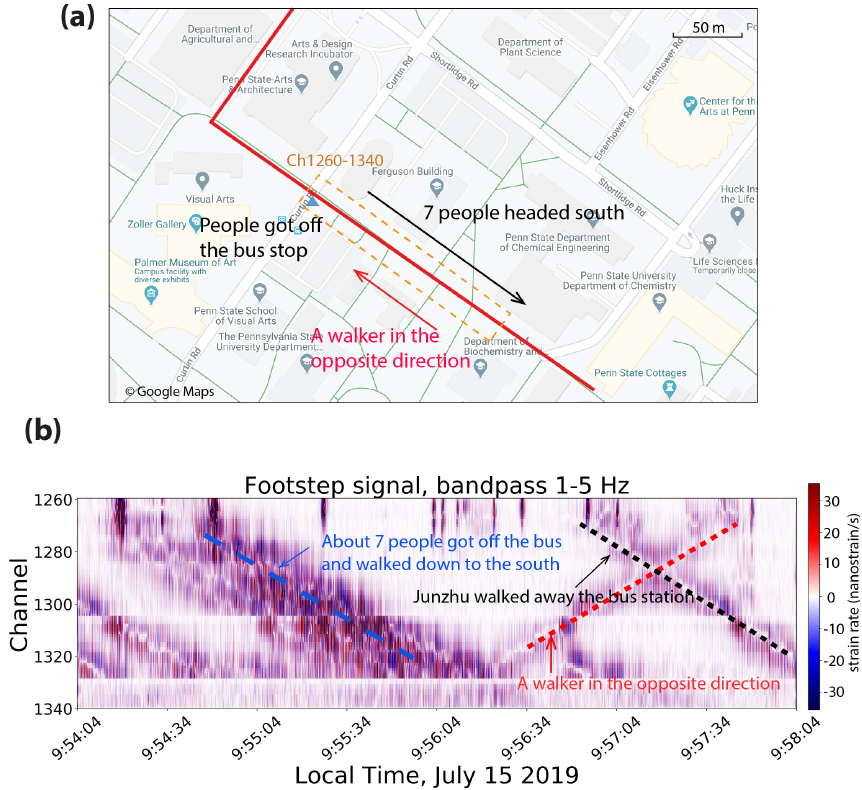
Figure 10. (a) Map of the array and walker information; (b) band-passed data between 1 and 5Hz. Dashed black and blue lines indicate a walker (author) and a group of walkers from the school bus walking away from the bus station (around channel 1270) along the fiber path, and later a walker moved towards the station. The slope of lines gives the walking speed of about 1.2ms − 1